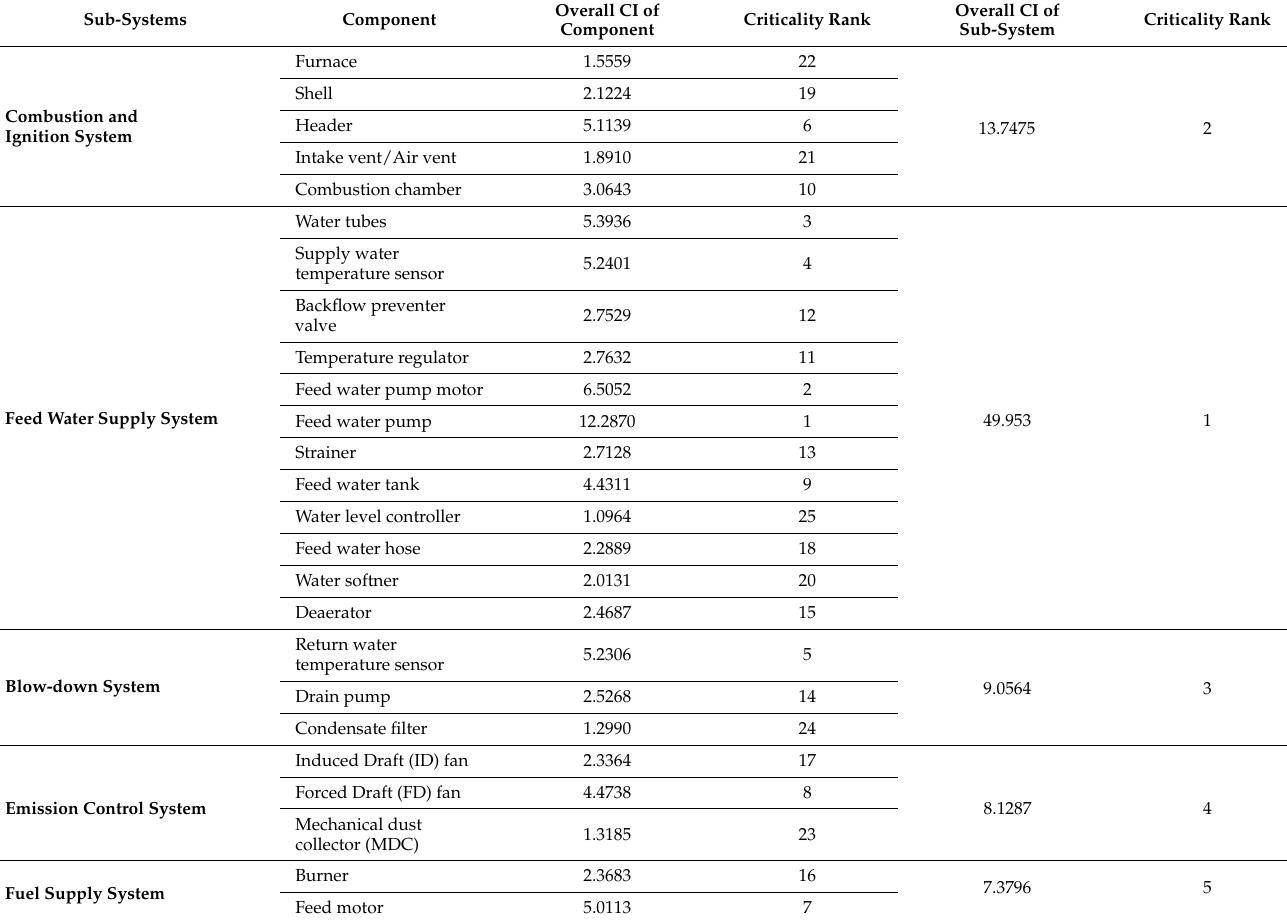
Table 12. Criticality Index and their criticality ranks of boiler sub-systems and